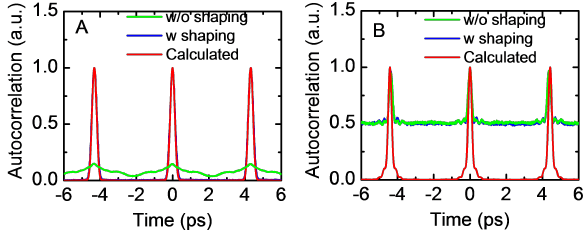
Figure 13: Autocorrelation traces for broadband (A) highly coherent comb and (B) incoherent comb. The comb line spacing is ~231 GHz. Measured results with (blue) and without (green) line-by-line shap- ing are shown. For the calculated results (red), a flat comb spectral phase is assumed. The data for panel B are provided by Pei-Hsun Wang in a private